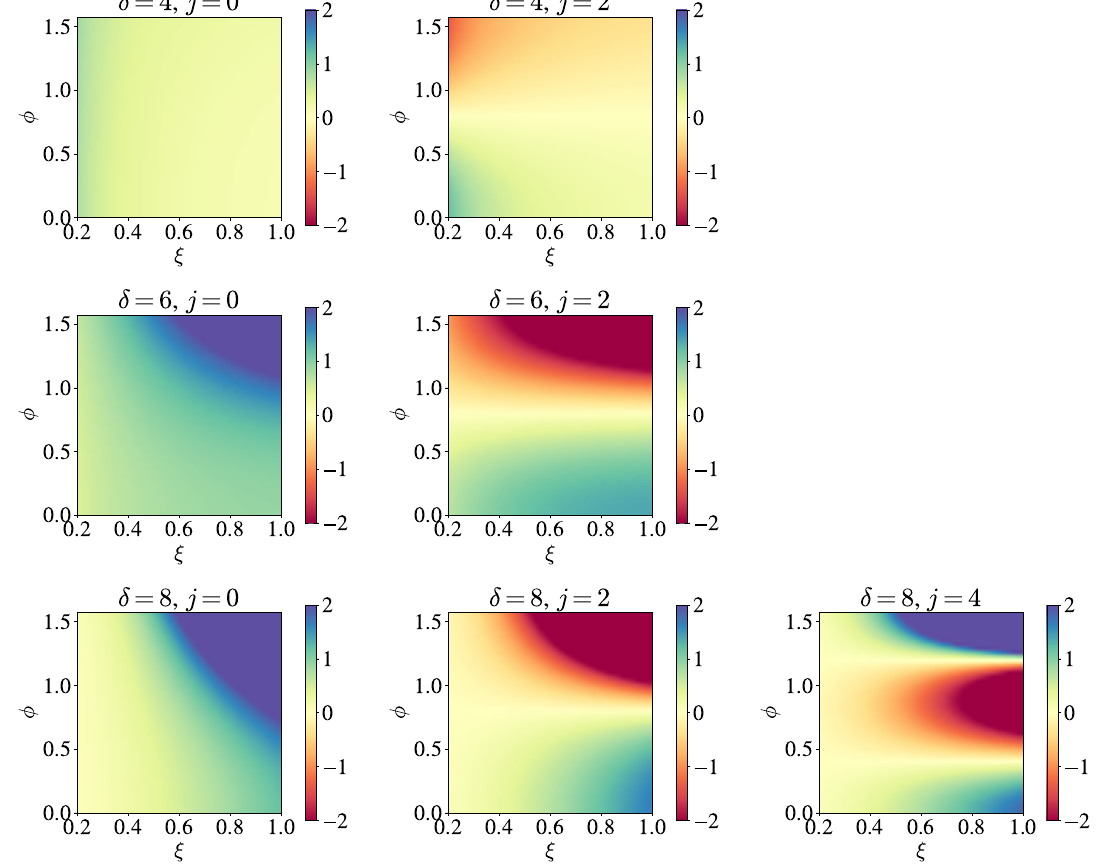
Figure 11. Plots of the celestial blocks for several low lying values of the celestial dimensions, δ , and transverse spins, j . In the higher transverse spin blocks, we see clearly the oscillatory behavior in φ , which is the azimuthal coordinate about the OPE limit. The full three-point correlator is decomposed as a sum over these blocks, much in analogy with a standard Fourier